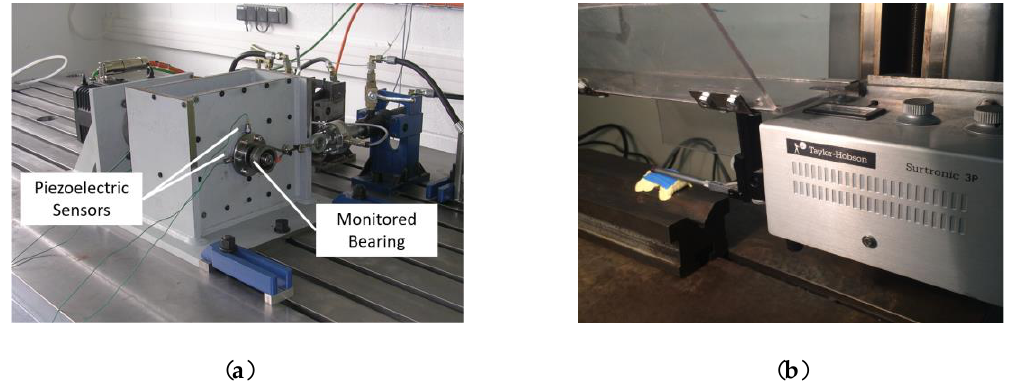
Figure 8. ( a ) Test bench ( b ) profilometer with Plastiform TM paste. Table 9. Dimensions of the defects: width (W), arithmetic roughness (Ra) and total roughness (Rt).